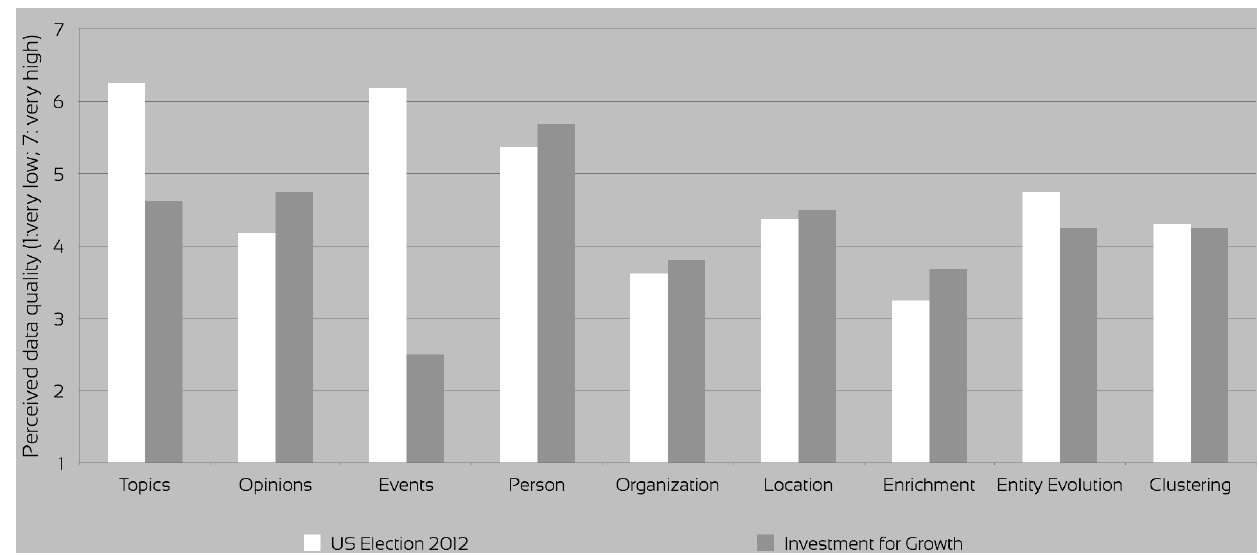
Figure 6. Perceived metadata